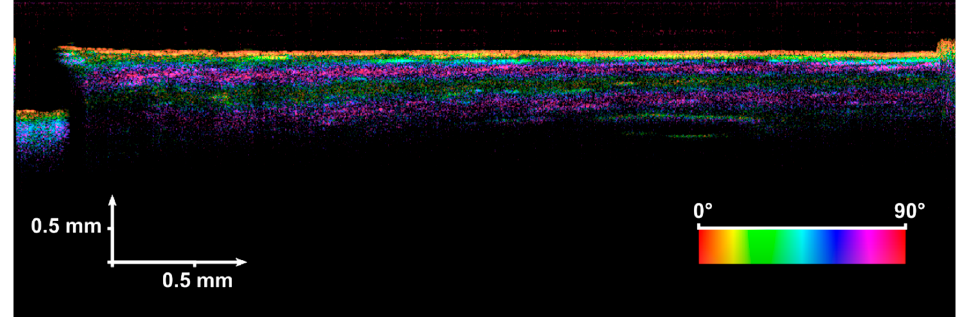
Figure 3. An example of PS-OCT imaging of the chicken humerus after 1 day of being exposed to 10% acetic acid (sample B14D_OCT).